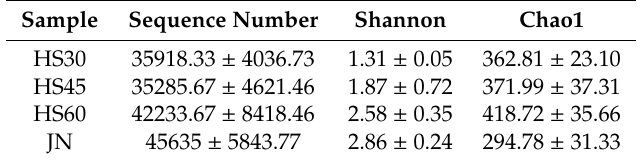
HS30: yellow water at 30th day, HS45: yellow water at 45th day, HS60: yellow water at 60th day, JN: pit